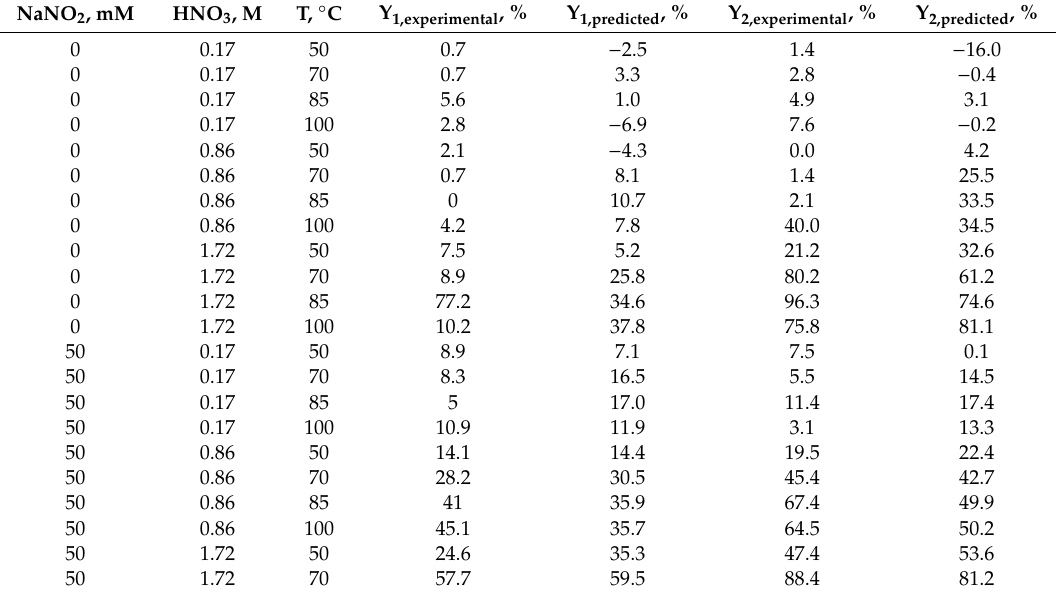
Table 1. Experiments performed under di ff erent conditions and the responses (TOC removal after 30 min, Y 1 , and TOC removal after 120 min, Y 2 ) obtained experimentally and predicted by the model. NaNO 2 ,